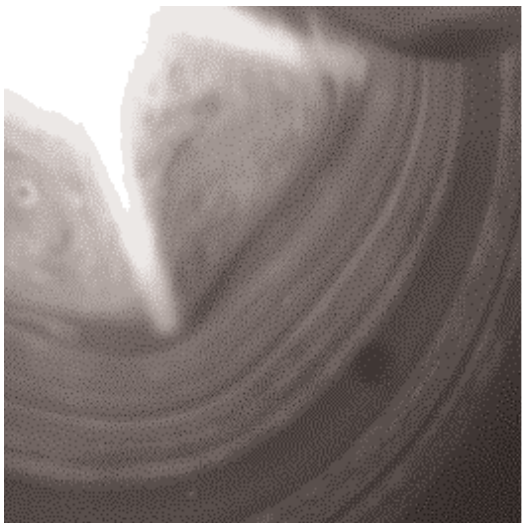
Figure 1: Visualization of streamlines around the vane for a glycerin solution of viscosity 1.375 Pas (Rotation speed: 0.5